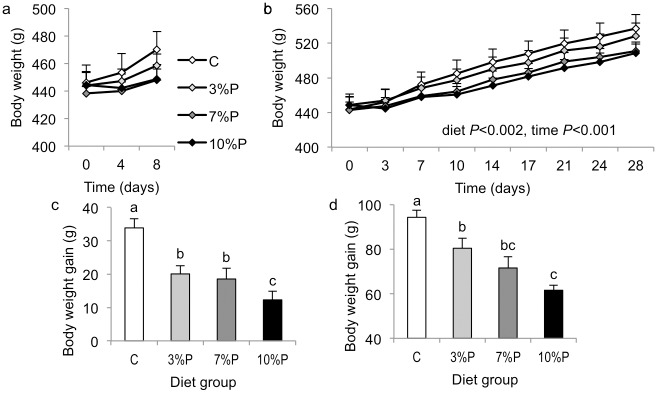
Body weight.Changes in body weight in rats offered control diet (C) or diet containing 3, 7 or 10% pectin (P) for 8 days (a, c) or 28 days (b, d). Results of repeated measures ANOVA are indicated in fig b. Within figures c and d, columns labelled with different letters are significantly different by one-way ANOVA, P<0.05.